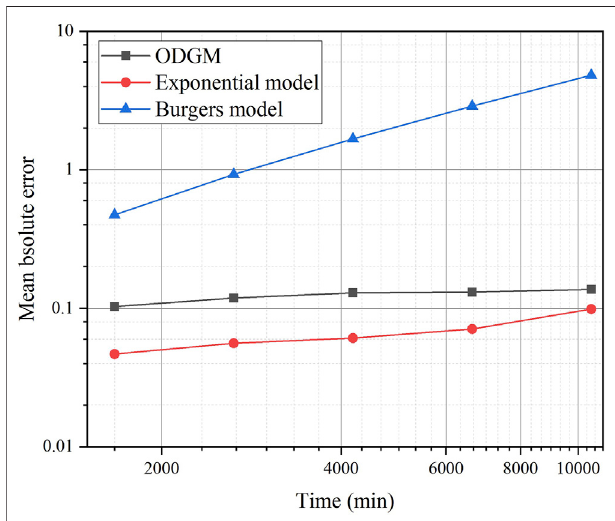
FIGURE 9 | Relationship of mean absolute error and time (log-scale) of three models in the process of